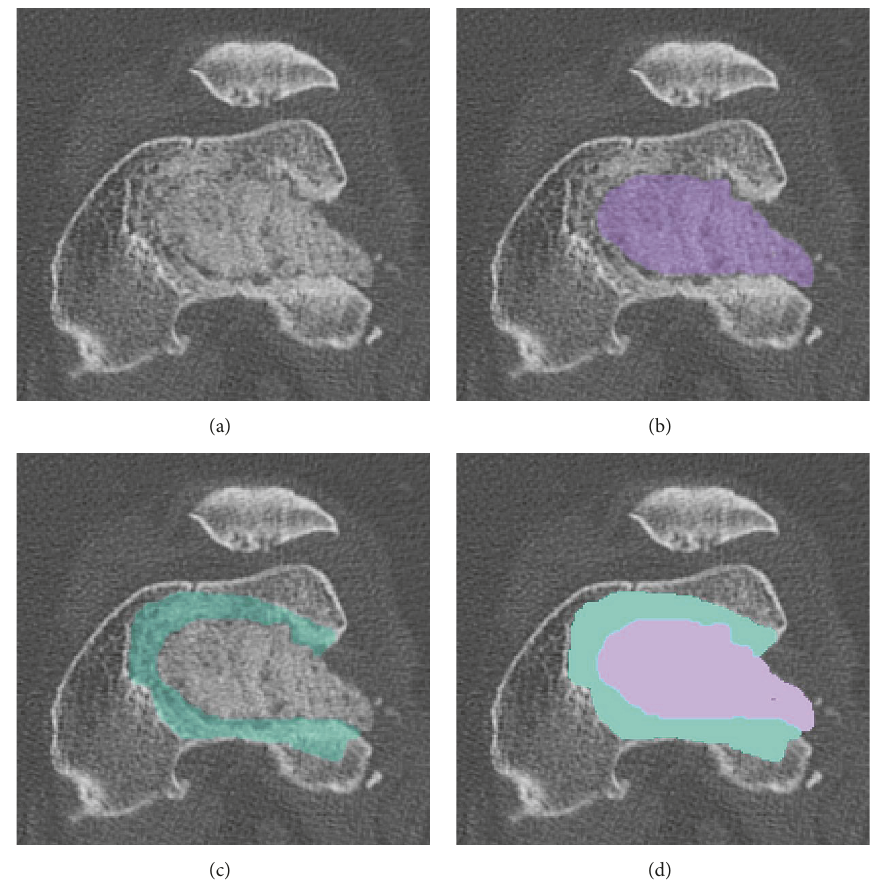
Figure 1: Axial section of distal femur with defect filled by TCP (a). The mask of the TCP (b) and new bone (c) are identified and combined